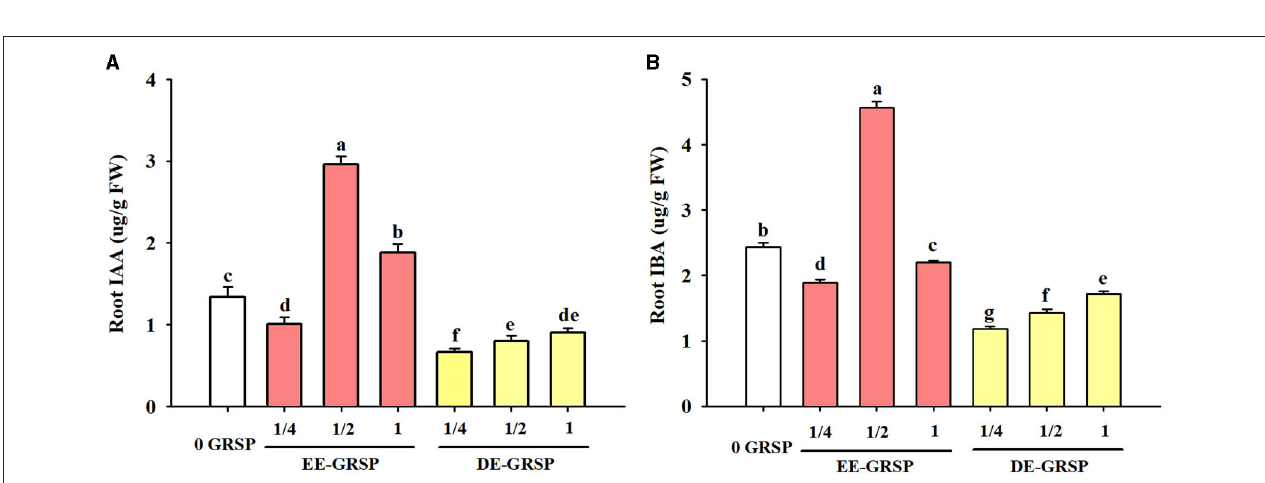
FIGURE 5 | Differences in the element content [ (A) : C, H, and O; (B) : N, P, K, Ca, and Mg; (C) : Cu, Al, Mn, Mo, Zn, and Fe] in purified EE-GRSP and DE-GRSP. Data (mean ± SD, n = 4) followed by different letters above the bars indicate significant differences ( p < 0.05). DE-GRSP, difficultly extractable glomalin-related soil protein; EE-GRSP, easily extractable glomalin-related soil protein.